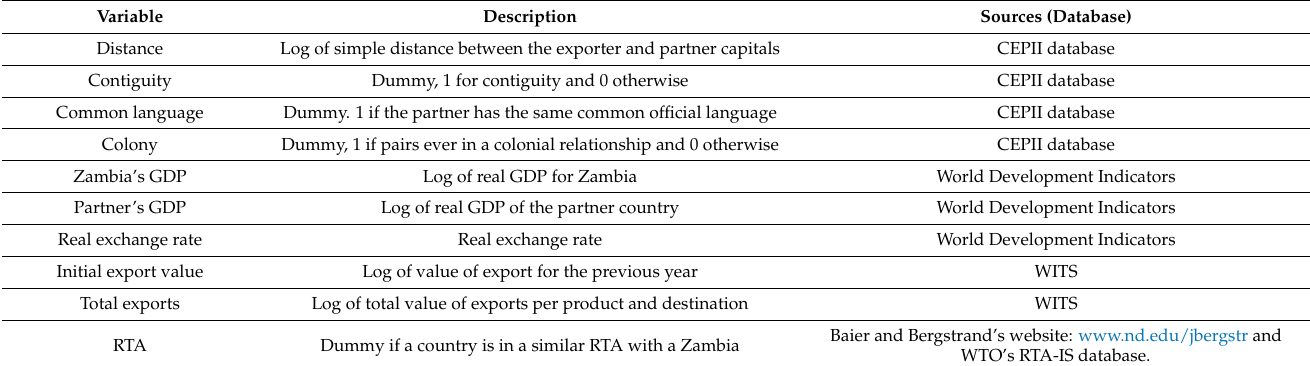
Table A1. Variable description and source of data. WITS, World Integrated Trade Solution.